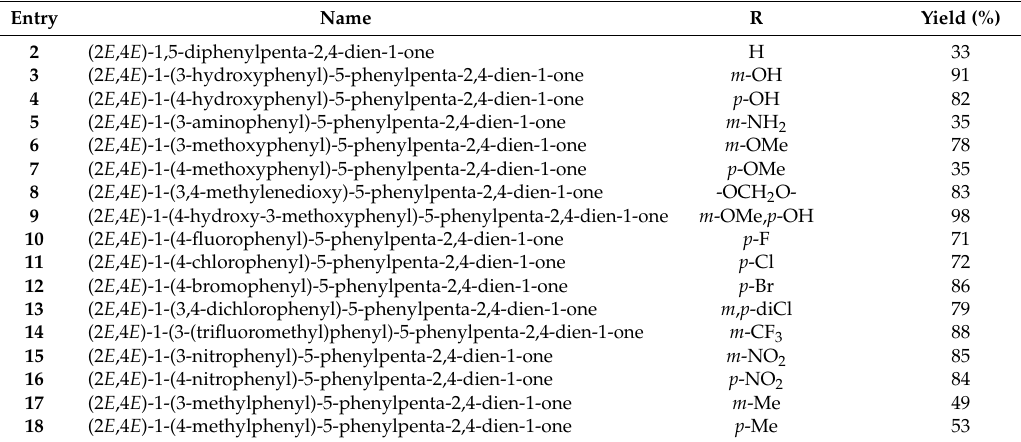
Table 1. Yields of